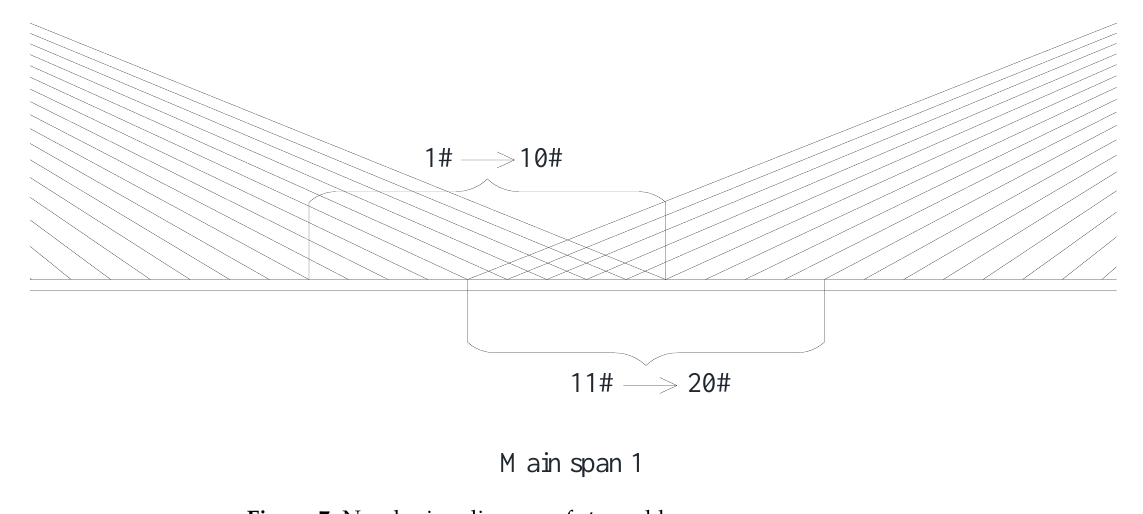
Figure 7. Numbering diagram of stay cables.